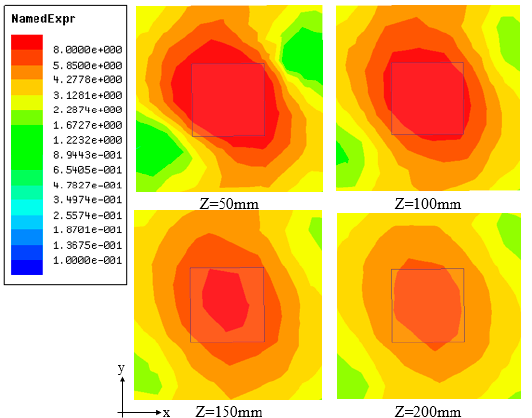
Figure 8. Simulation of the distribution of the electric field component Ey at different